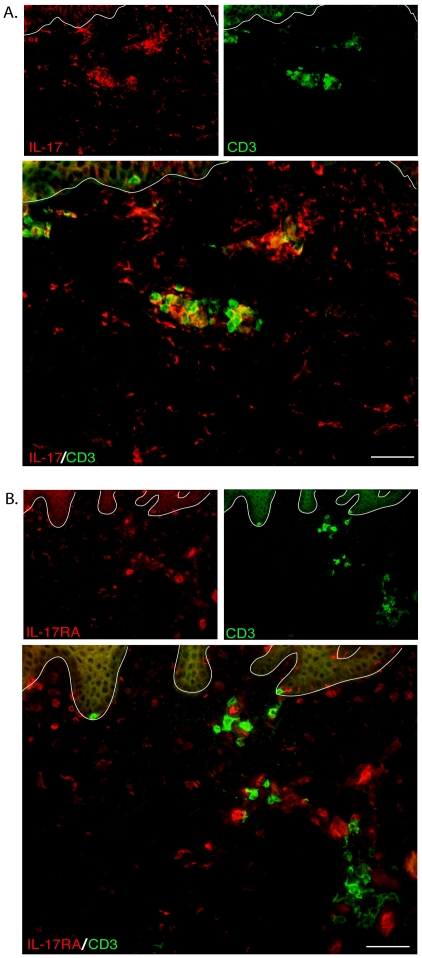
Detection of IL-17A producing T cells in vitiligo skin
biopsies.Double immunofluorescent staining of IL-17A/IL-17RA with CD3 on leading
edge vitiligo skin biopsies. (A) Co-staining of CD3 and IL-17A reveals
IL-17A+ T cells in vitiligo skin biopsies, but overlapping signals
were only found on a small number of CD3+ cells. IL-17A signals on
CD3 negative cells may reflect IL-17A molecules that are receptor bound.
(B) Co-staining of CD3 and IL-17RA does not show any overlapping signals
across the three groups of vitiligo biopsies, which indicates that
receptor bound IL-17A are not likely to colocalize with CD3+ T
cells. Bar = 100 mm, applies to 6A&B.